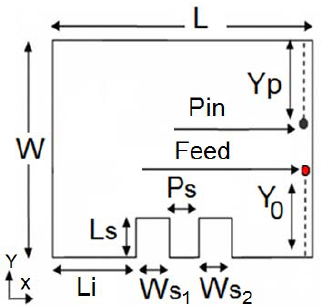
Figure 1: Geometry of proposed